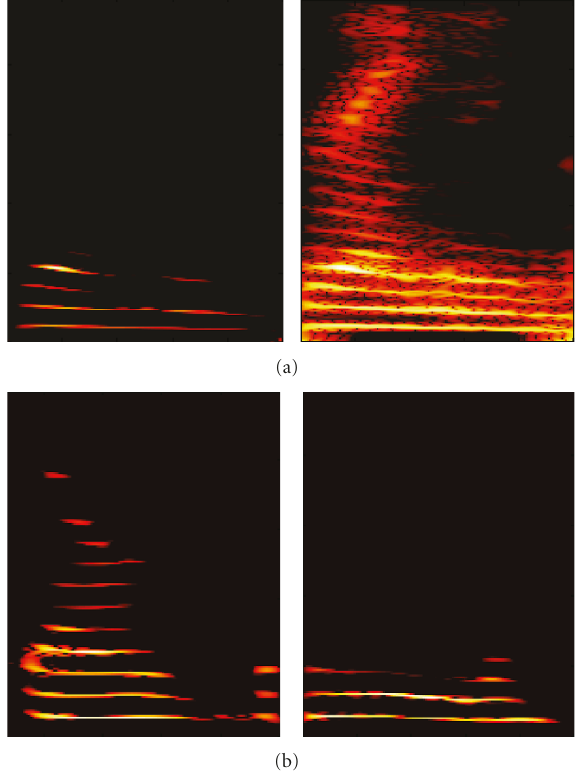
Figure 5: (a) The components selected by two di ff erent thresholds ξ 1 and ξ 2 ( ξ 1 > ξ 2 ) within the same region. (b) The components selected within two di ff erent regions when the threshold is 0 . 6 · 10 0 . 6log 10 (max | SM | ) .